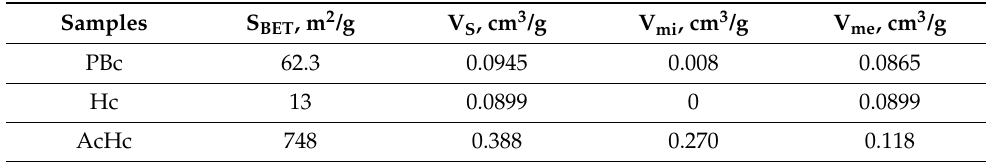
Table 1. Specific surface area and porosity of